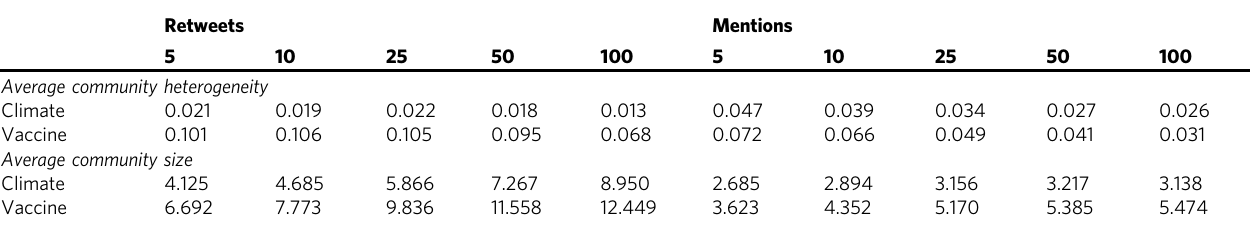
Table 5 Vaccine conversation communities are larger and contain more diversity of user